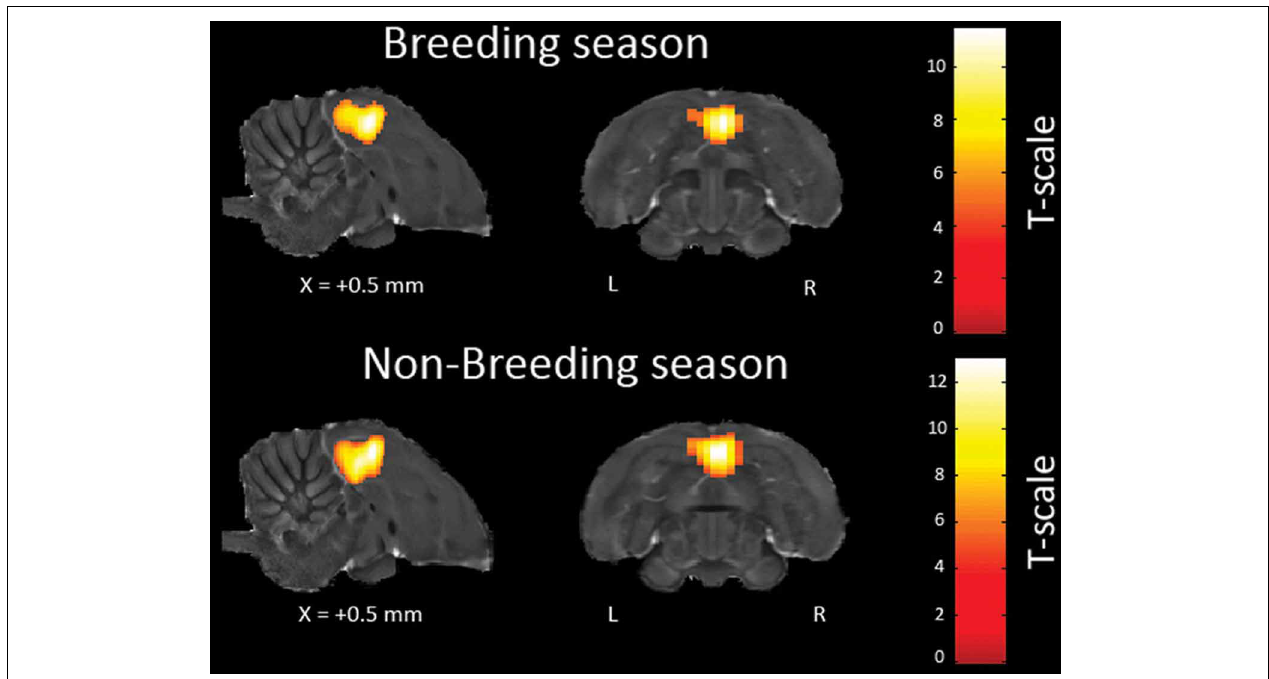
FIGURE 2 | Activations induced in the same individual by all the auditory stimuli (vs. rest) across seasons. The statistical parametric maps (unilateral one sample t -test) are superimposed on anatomical sagittal and axial images coming from the high-resolution starling image. They illustrate the bilateral activation of Field L, the equivalent of the mammalian primary auditory cortex, and the (caudally and frontally)